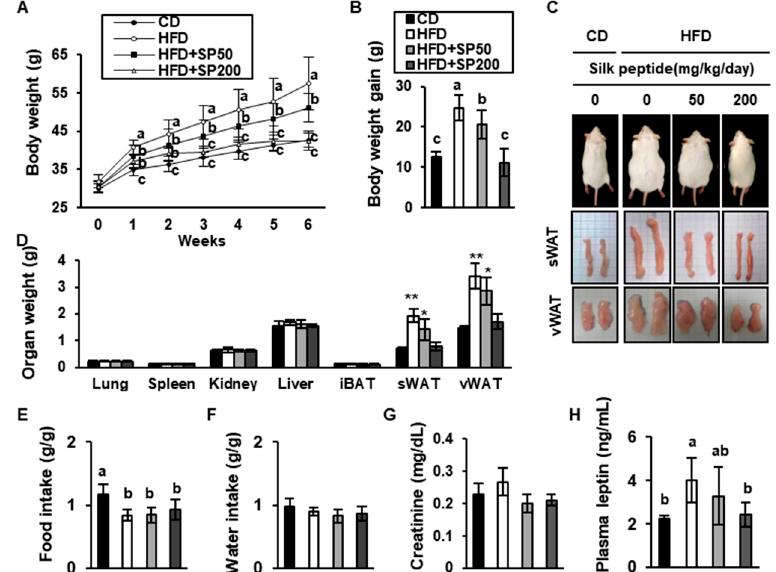
Figure 4. Silk peptide prevents the development of diet-induced obesity in HFD-induced obese mice. ( A ) Weekly body mass measurements, ( B ) body mass gain, and ( C ) photographs of representative mice treated for 6 weeks. ( D ) E ff ect of SP on organ mass in the CD and HFD groups. * p < 0.05 and ** p < 0.01 indicates significantly di ff erence from CD group. ( E ) Food intake and ( F ) water consumption per unit body mass. Serum ( G ) creatinine and ( H ) leptin concentrations were measured using colorimetric kits. Data are expressed as mean ± SD ( n = 8). Values with di ff erent letters were significantly di ff erent; p < 0.05 (a > ab > b >